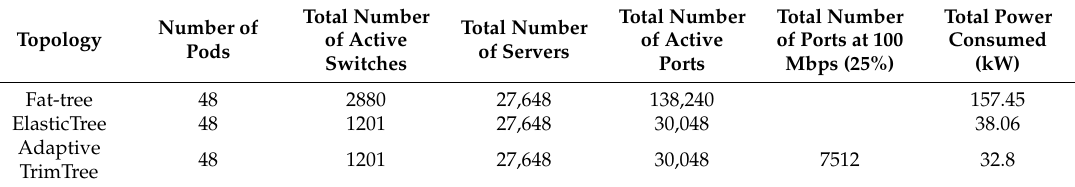
Table 3. Power consumption in Fat-Tree, ElasticTree (MST) and Adaptive TrimTree.